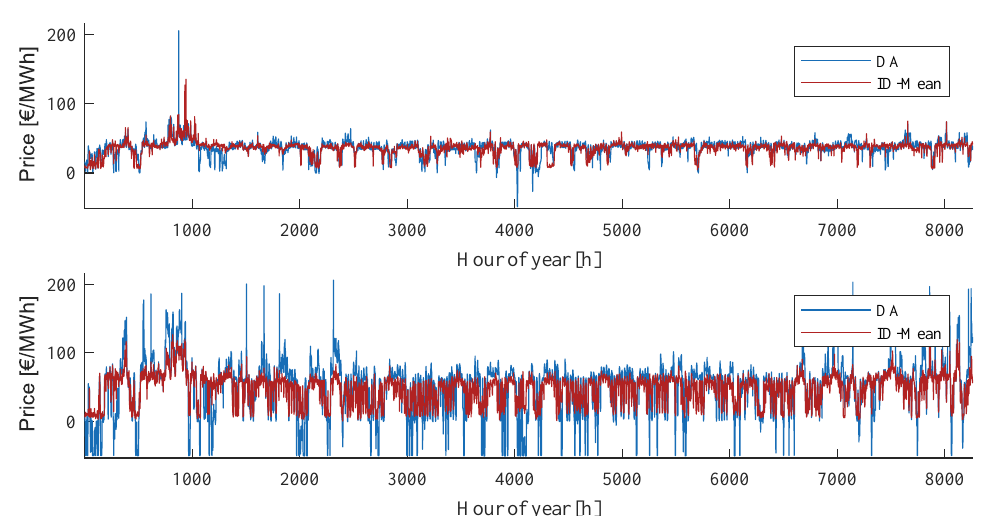
Figure A3. DA and ID electricity price for the simulation year in an hourly resolution for 2023 ( top ) and 2035 ( bottom